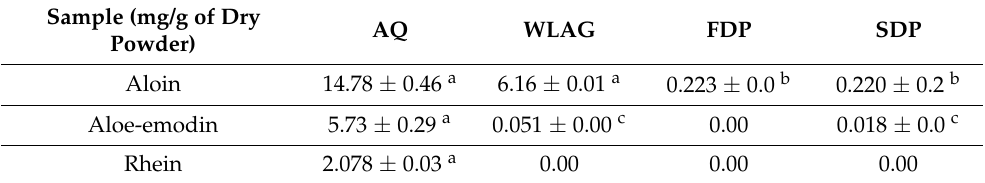
Table 1. Concentrations of Anthraquinones in WLAG, SDP, FDP and AQ powder. Sample (mg/g of Dry AQ WLAG Powder) Aloin Aloe-emodin 5.73 ± 0.29 a Rhein 0.00 0.00